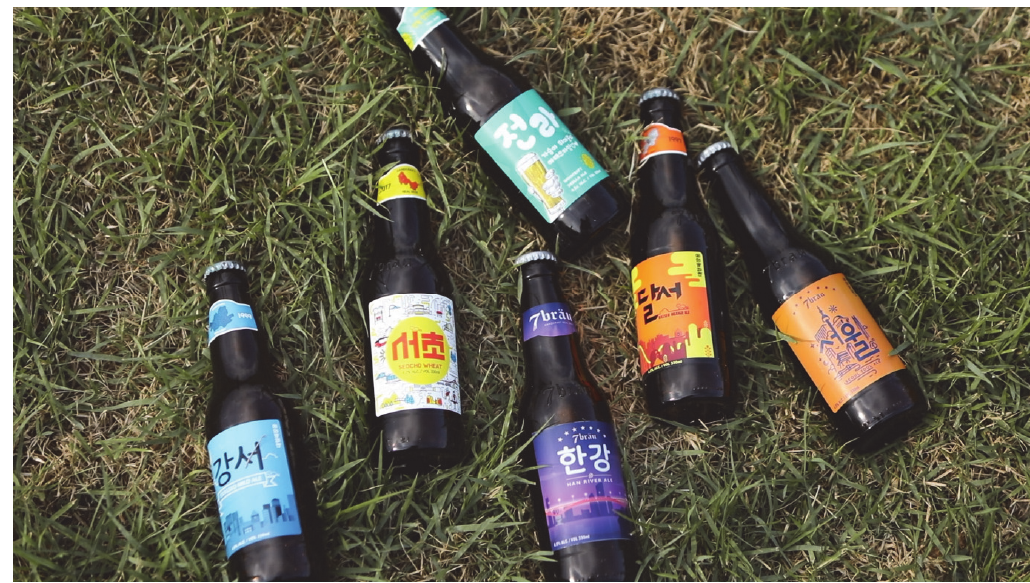
<Figure 2> SevenBr ä u’s Region-Labeled